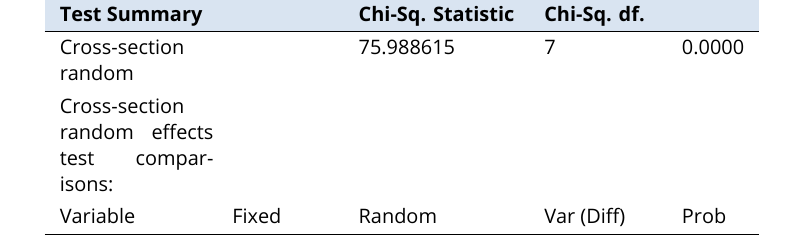
Hausman Test of IFRS Transition Period –